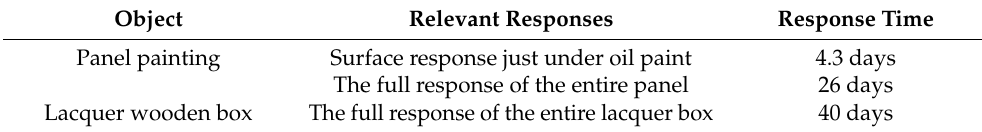
Table 4. Relevant responses and corresponding response times for different objects, according to